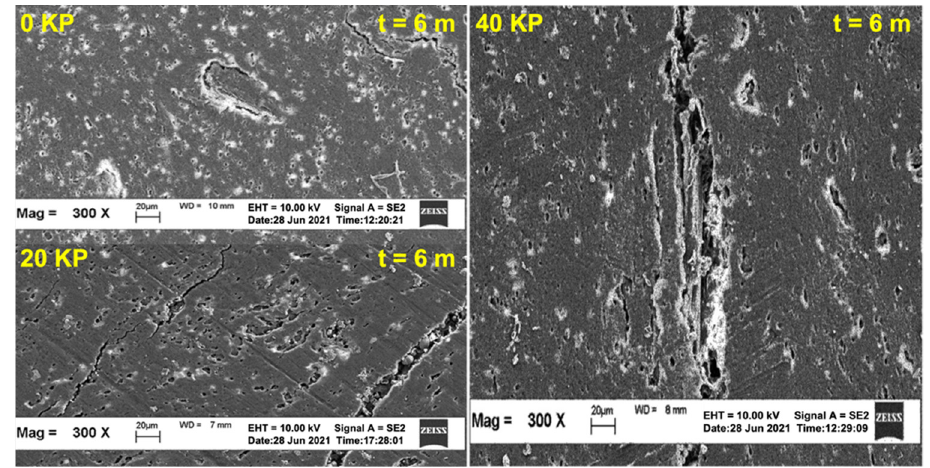
Figure 10. SEM micrographs at 300× magnification of KP-filled rHDPE/NR blends before and after 6 and 12 months of natural weathering.